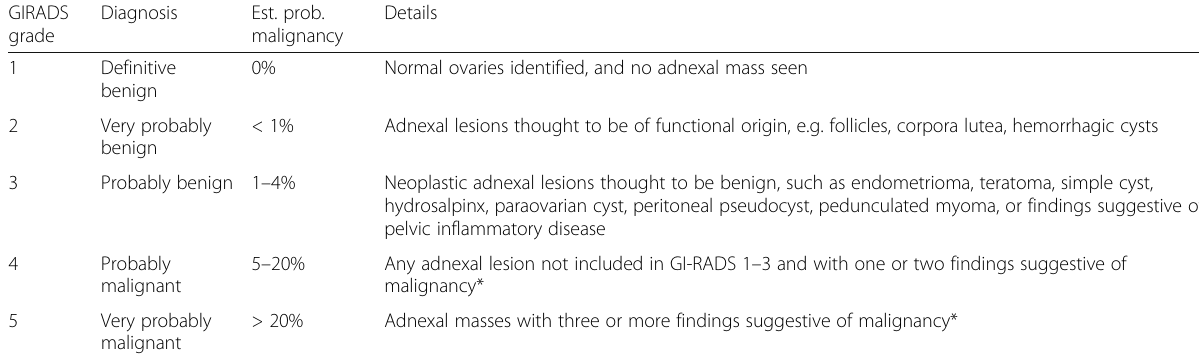
Table 1 GI-RADS classification system for adnexal masses [11] GIRADS